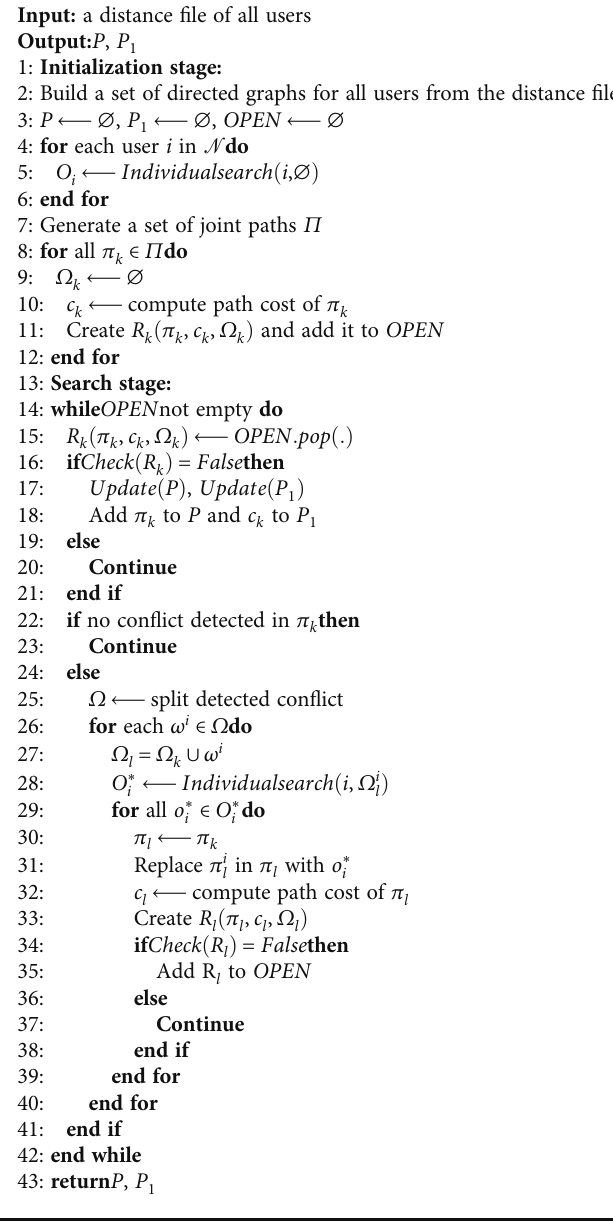
Algorithm 1: Pseudocode for CR-MOMAPF-based handover strategy. Table 1: Scene